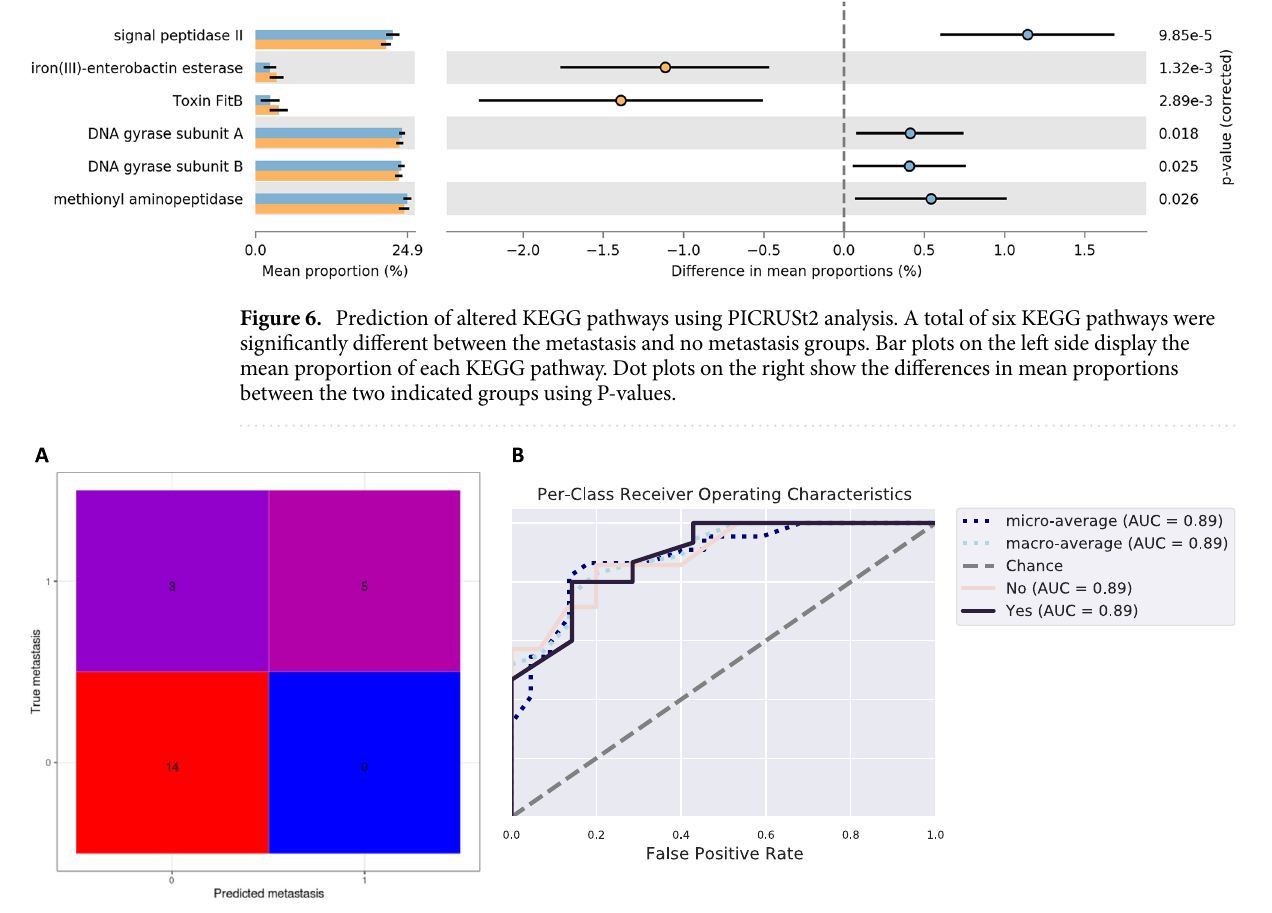
Figure 7. Evaluation of the prediction model for lymph node metastasis in oral squamous cell carcinoma. Confusion matrix ( A ) and the average receiver operating characteristic curves from the machine learning-based models ( B